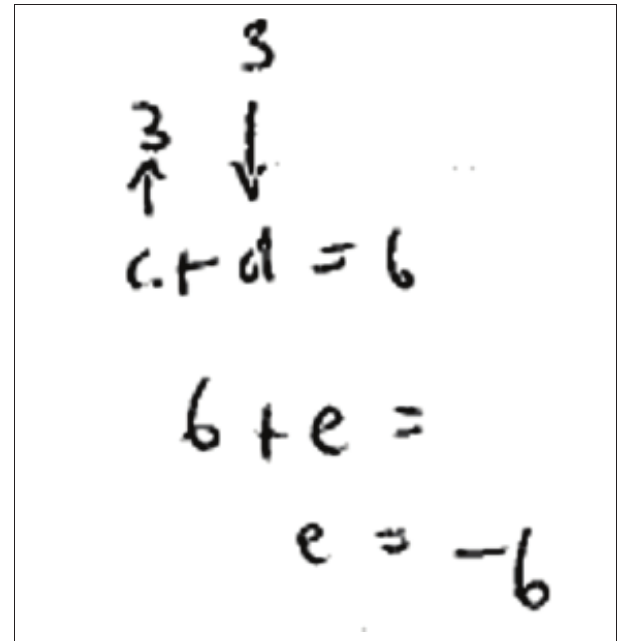
FIGURE 1: Bokang’s response to ‘if c + d = 6, then c + d + e =